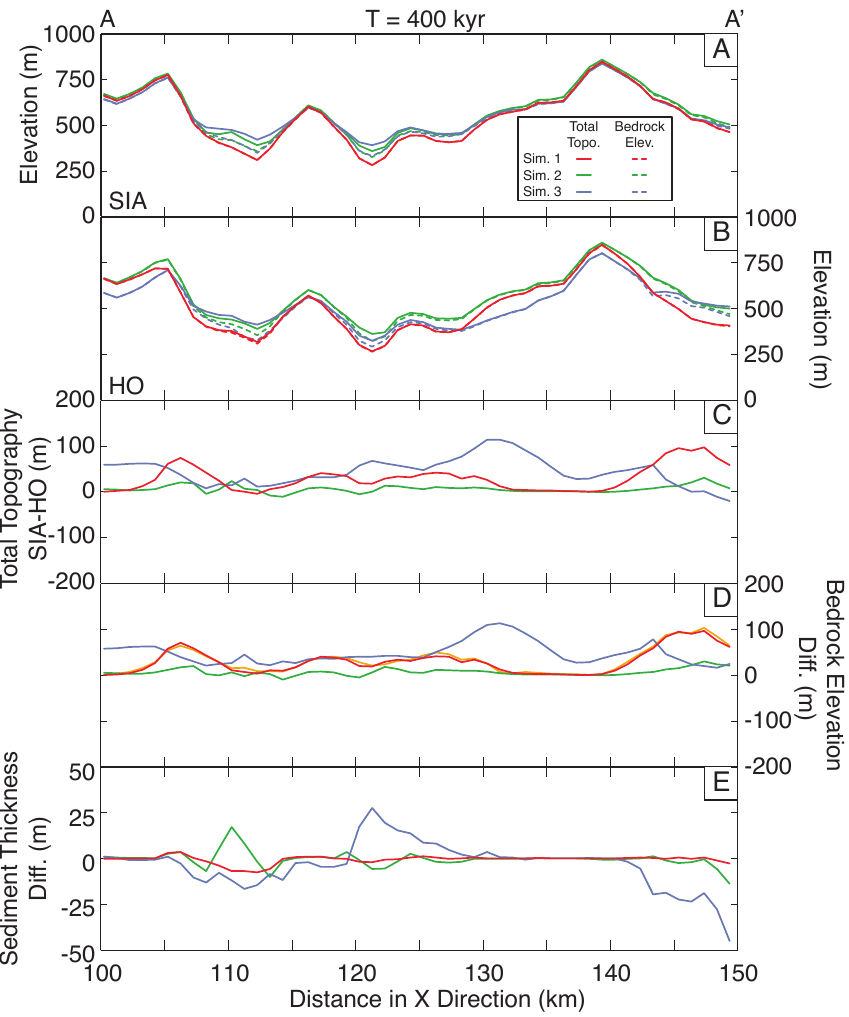
Figure 9. (a–c) Topographic swath profiles over the A–A’ orogen-parallel swath (Fig. 1). Solid lines indicate the ice-bed topography contact, and the dashed lines indicate the bedrock elevation (sediment is allowed to accumulate in ICE-Cascade). (a) SIA topographic profiles at the end of the full simulation. (b) HO topographic profiles at the end of the full simulation. (c) Differences between the topographic profiles erosion rates (SIA–HO). (d) Differences between the bedrock topography (SIA–HO). (e) Differences between the sediment thicknesses